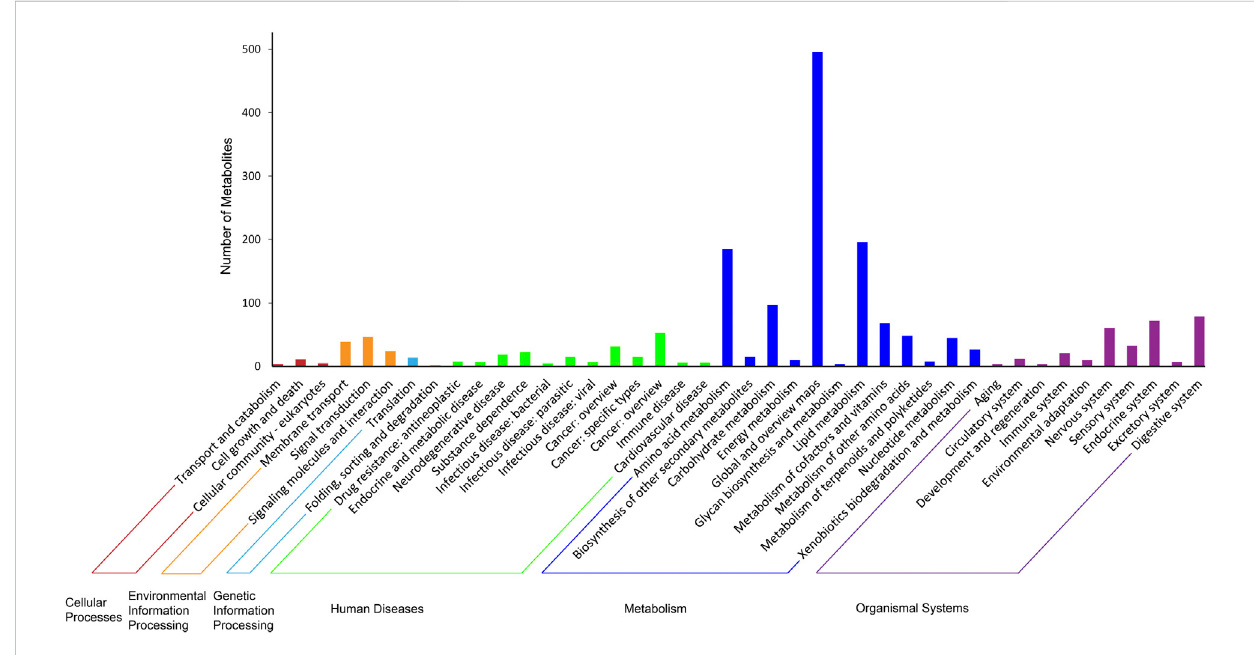
FIGURE 4 The KEGG categories of all identi fi ed metabolites.